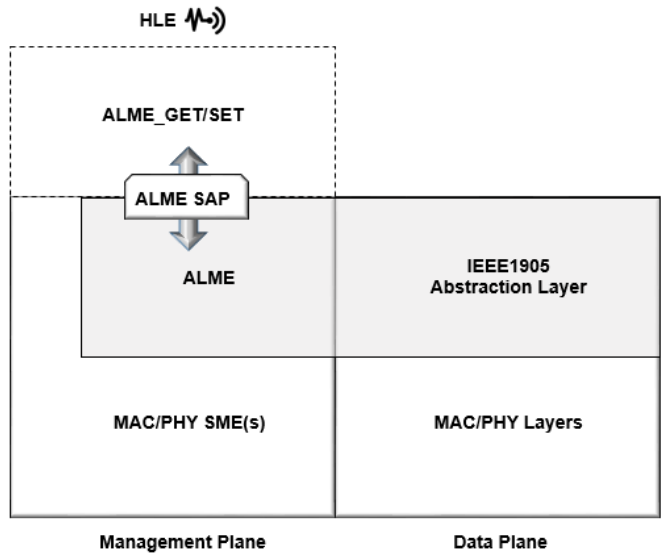
Figure 11. IEEE 1905 standard network management